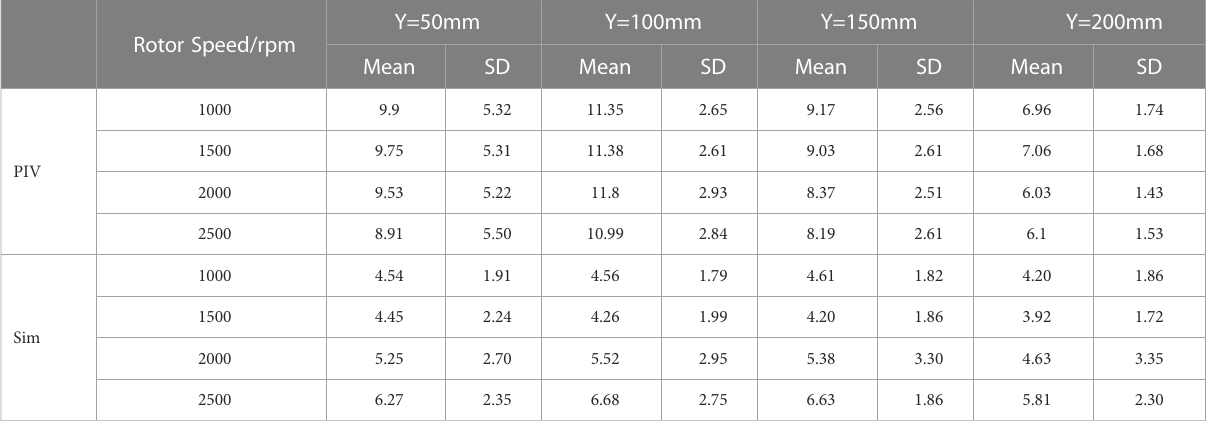
TABLE 3 The mean value and variance results of PIV test and numerical simulation.